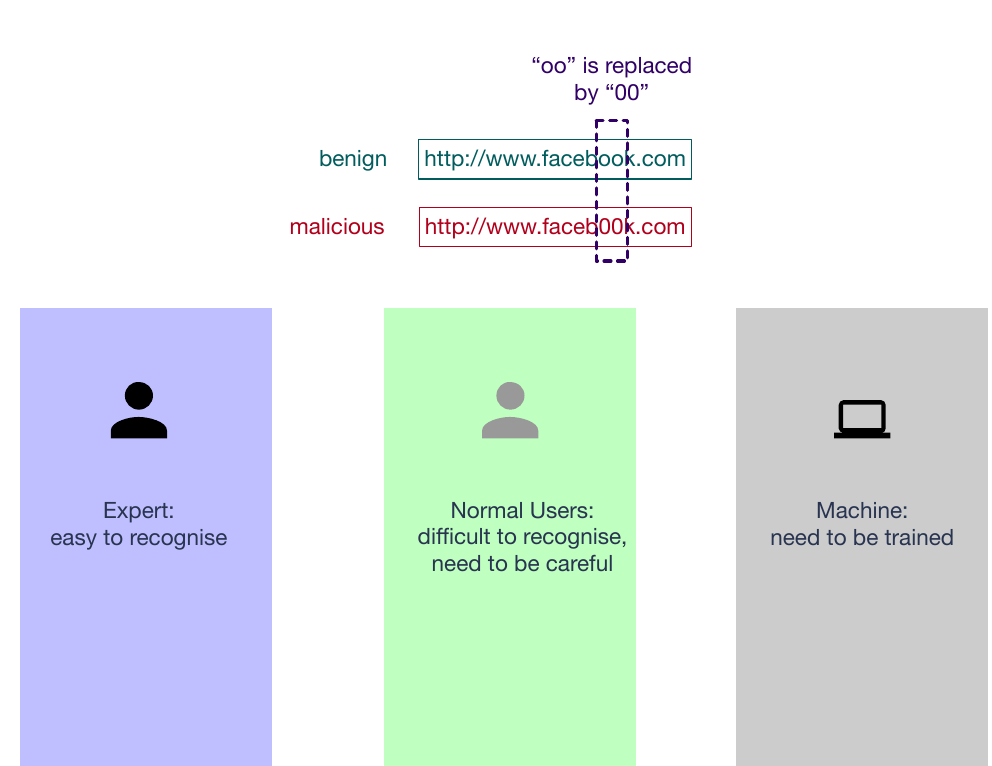
Figure 2. Difficulties to recognise malicious URLs for experts, normal users, and machines.